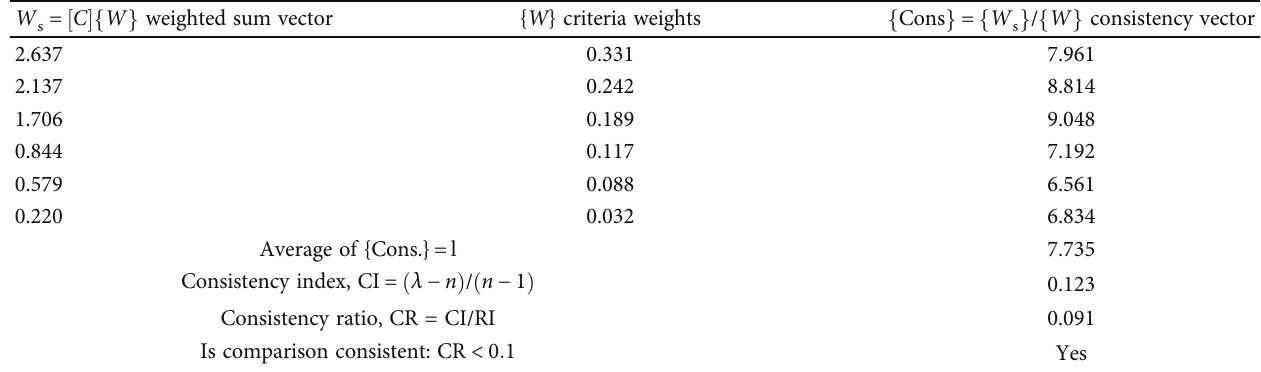
Table 5: Consistency check for W